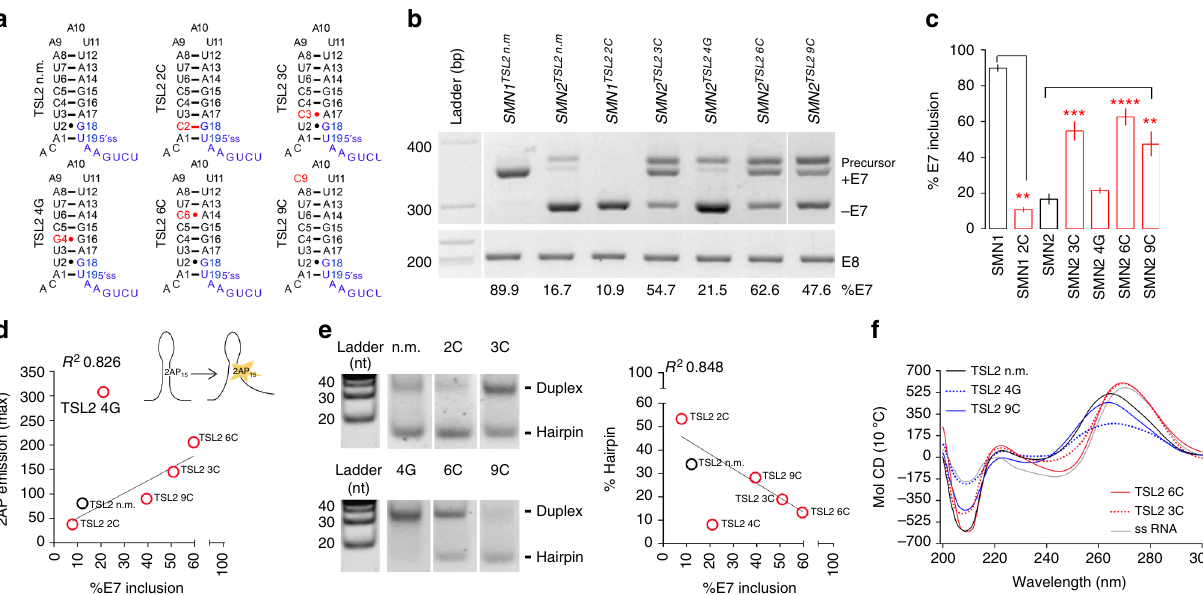
Fig. 1 Structural mutations in TSL2 affect SMN2 exon 7 inclusion. a Predicted secondary structure of non-mutated (n.m.) TSL2 or TSL2 carrying the indicated mutations (red). The 5 ′ splice site (5 ′ ss) of exon 7 (E7) is shown (blue). b , c Agarose gel image showing RT-PCR products from HeLa cells transfected with SMN E6 − to − 8 minigenes 16 carrying either n.m. TSL2 or mutated TSL2. Mutations that disrupt the TSL2 stem (3C, 4G and 6C) and a